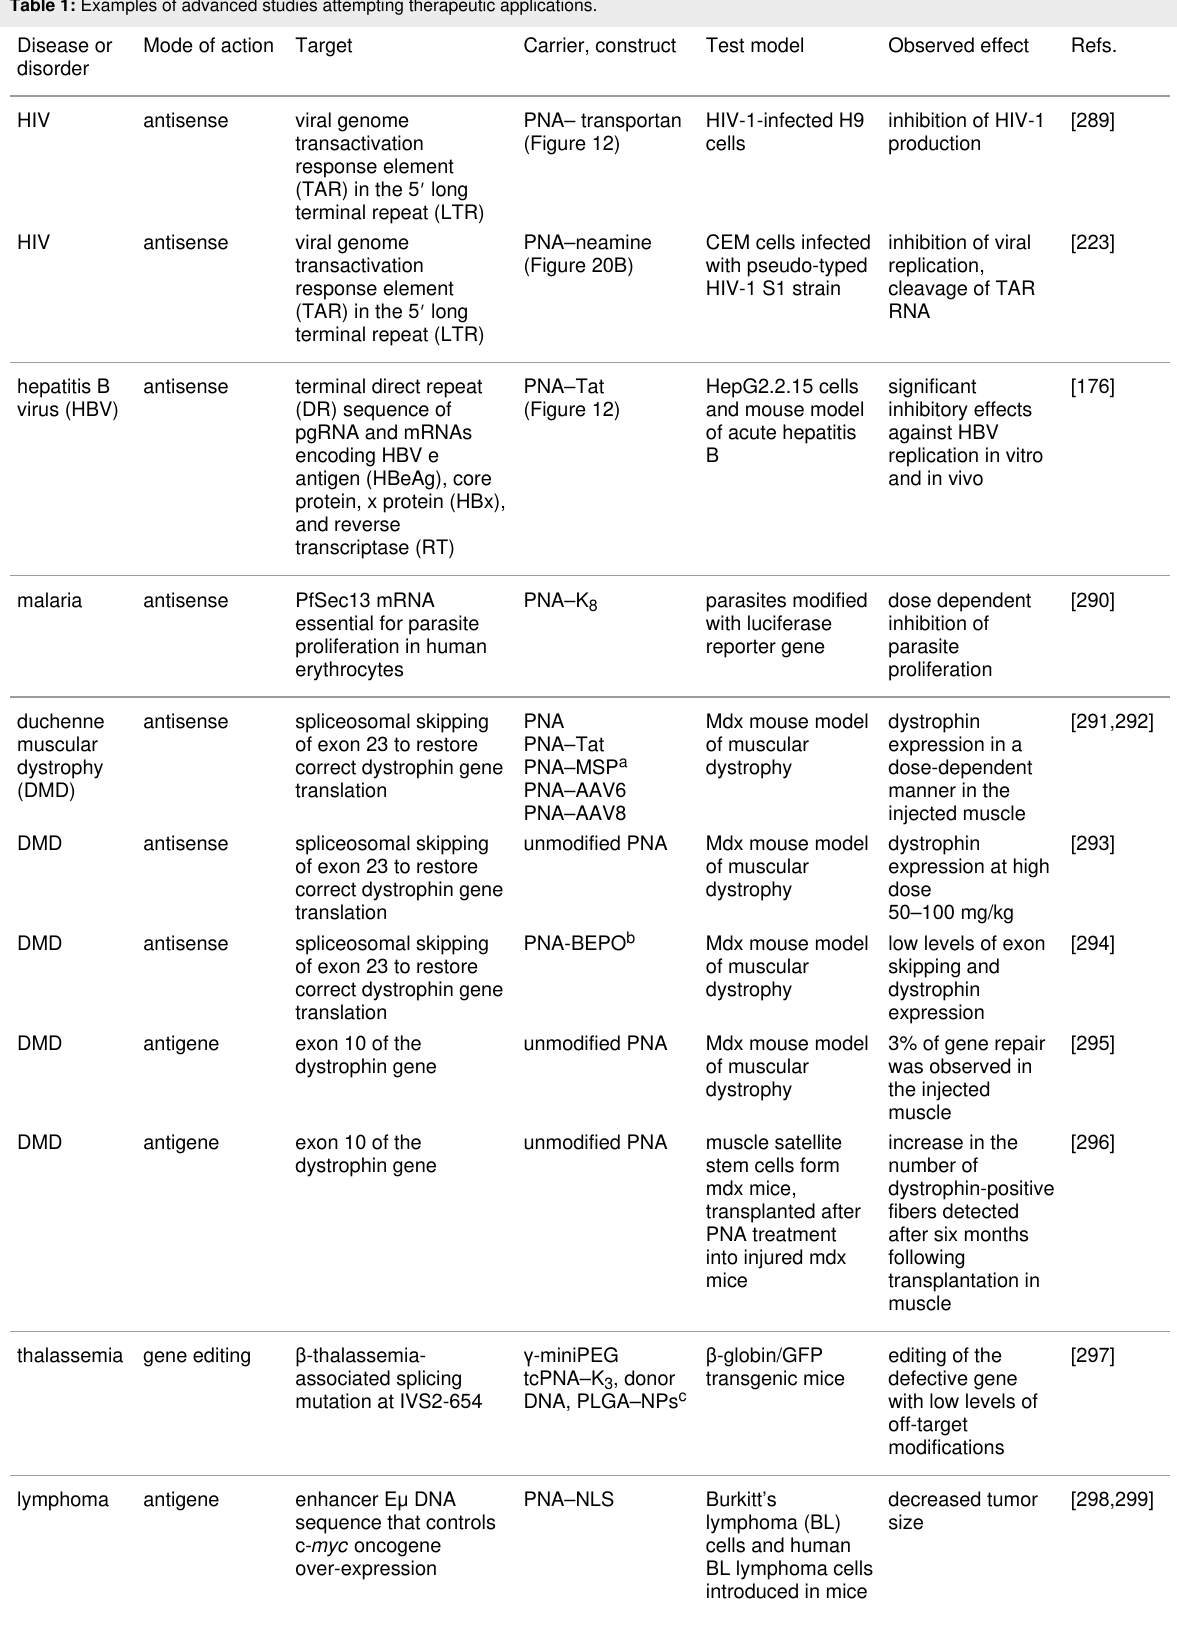
Table 1: Examples of advanced studies attempting therapeutic applications. Disease or